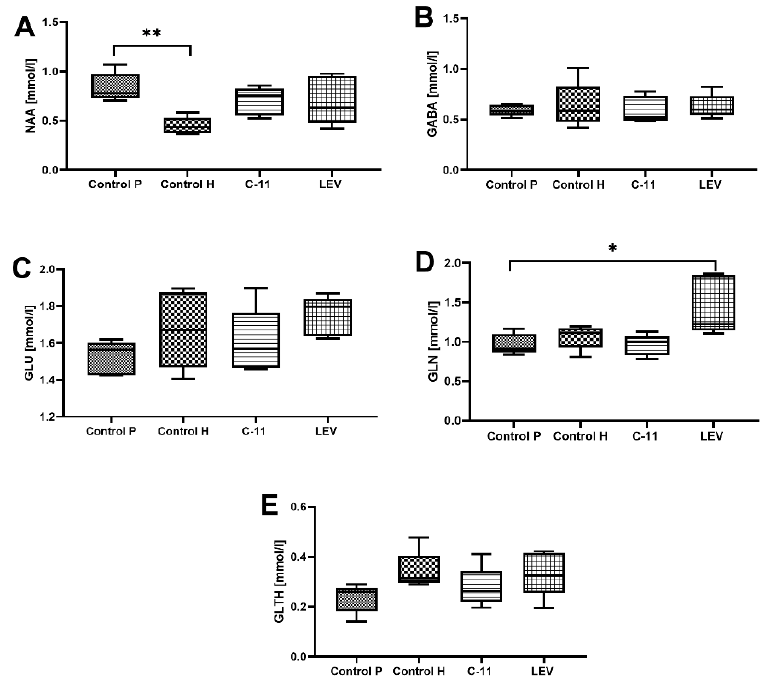
Figure 4. Evaluation of the long-term C11 and LEV administration on the level of ( A ) NAA; ( B ) GABA; ( C ) GLU; ( D ) GLN and ( E ) GLTH in mice of after PILO-induced SE. Experiments were performed on a 7T MRS scanner. Abbreviations: NAA—N-Acetyl Aspartate, GABA—Gamma-Amino Butyric Acid, GLU—Glucose, GLTH—Glutathione, GLN—Glutamine. The results were analyzed using one-way analysis of variance (ANOVA), followed by Dunnett’s test for multiple comparisons. Each bar represents the mean for five mice; error bars are S.E.M. * p < 0.05 and ** p < 0.01; n = 5).